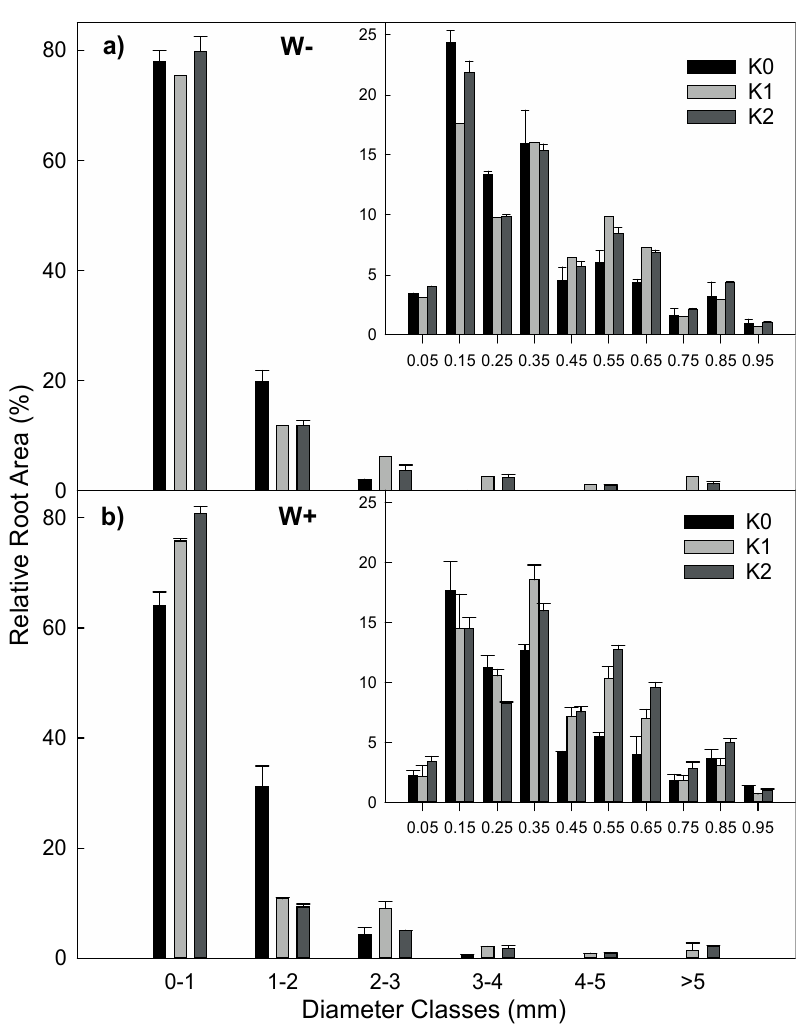
Figure 5. Distribution of relative root area (%) by root diameter classes (mm) for ( a ) well-watered (W+) and ( b ) water-stressed (W − ) corn plants growing under low potassium (K0), normal potassium (K1), and high potassium (K2) levels (mean ± Standard Error; n = 2); insert represents the detailed distribution of relative root area between 0 to 1 mm.